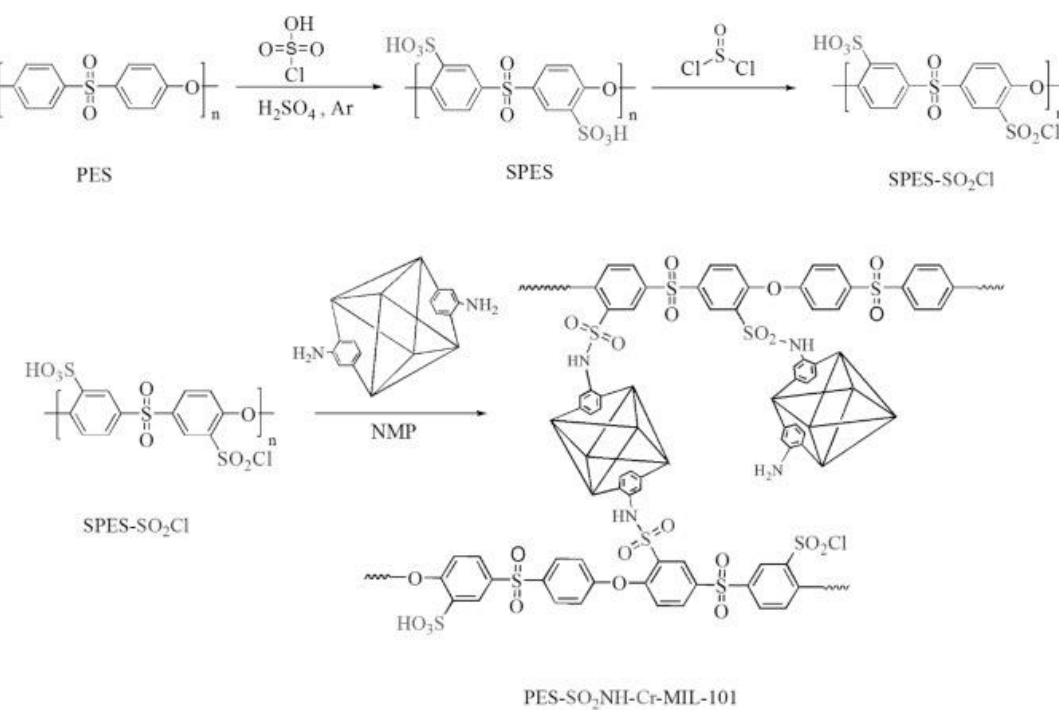
Figure 3. Schematic of the procedure for the synthesis of PES-SO 2 Cl with Cr-MIL-101 2 metal organic framework (MOF), utilized as PA-doped PEM for HTPEMFC [59].